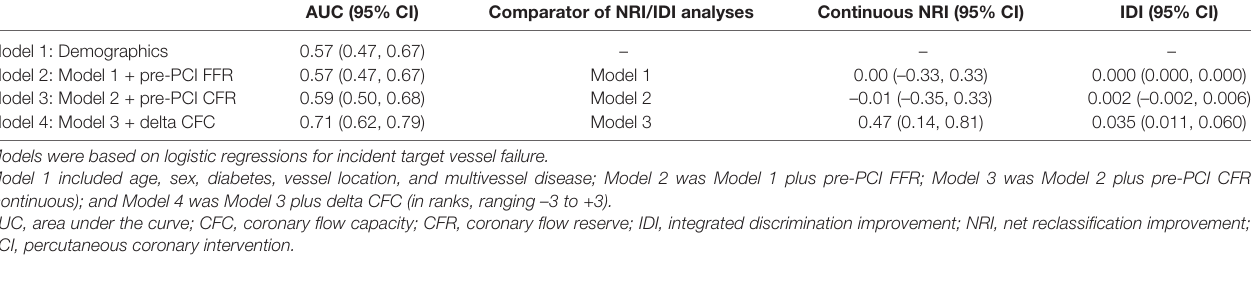
FIGURE 5 | Kaplan–Meier curves showing survival from TVF according to the post-PCI CFC categories. Kaplan–Meier curves showing survival from TVF according to pre- (A) and post-CFC status (B) . CFC status was categorized as severely reduced, moderately reduced, mildly reduced, and normal. Numbers indicate the number of patients at risk. TABLE 7 | Prediction incident target vessel failure based on pre-PCI information. AUC (95% CI) Comparator of NRI/IDI analyses